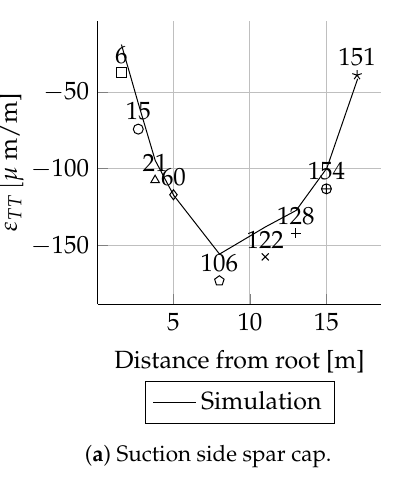
Figure A2. Strain comparison ε LL for Mxmax load